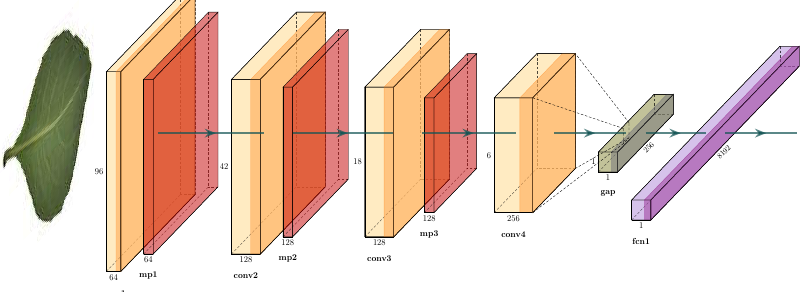
Figure 4. Convolutional architecture: convolutional neural networks (CNN).